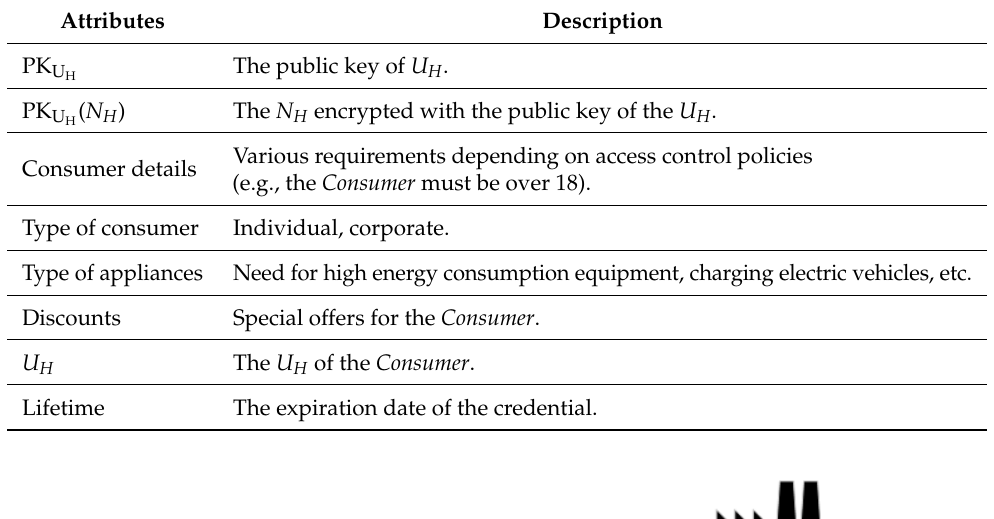
Table 2. P4G2Go credential attributes.